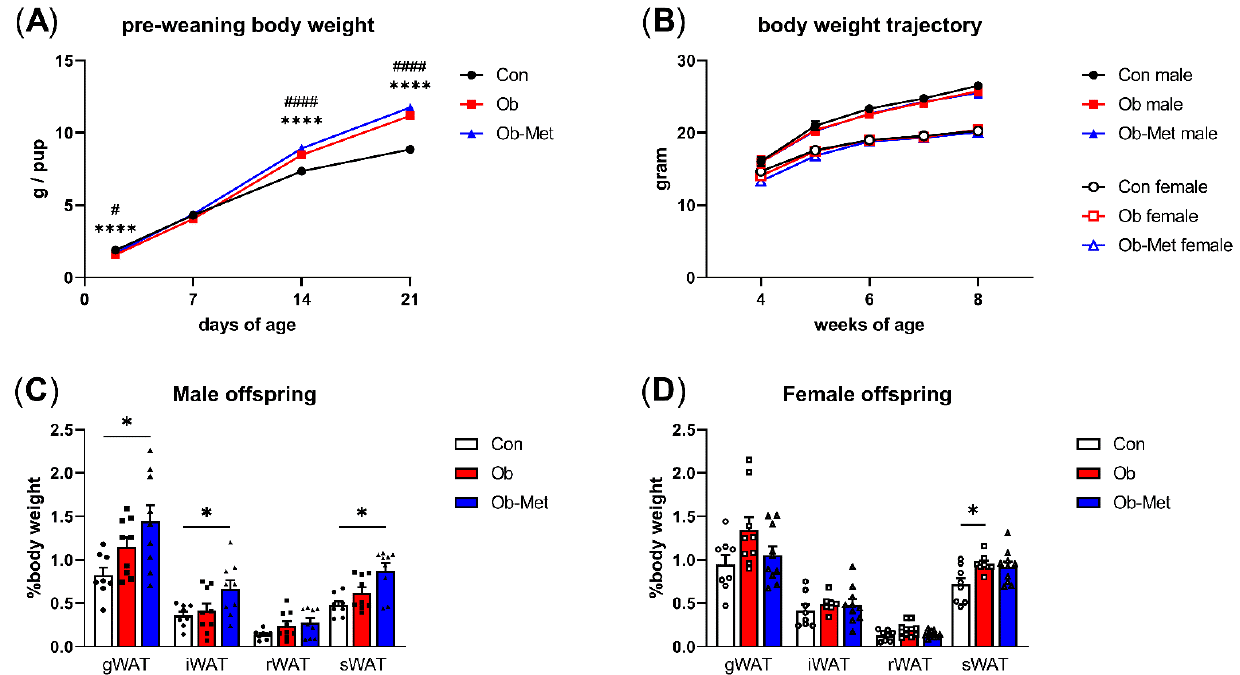
Figure 1. Offspring growth and adiposity in 8-week-old offspring. ( A ) Growth trajectory of neonatal offspring (n = 26–33 independent litters per group, sexes combined). **** p < 0.0001 vs. Con vs. Ob, # p < 0.05, #### p < 0.001 Con vs. Ob-Met using two-way ANOVA with Tukey’s multiple comparison test. ( B ) Post-weaning body weight trajectory in male and female offspring until 8 weeks of age (n = 10–14 independent litters per group). ( C , D ) Weight of white adipose tissue (WAT) depots collected at 8 weeks of age relative to offspring body weight (n = 8–10 independent litters per group). Outliers were excluded from ( C ) iWAT and sWAT; female Ob (Grubb’s method, outlier excluded values 1.03% and 1.45%, respectively). * p < 0.05 using one-way ANOVA with Tukey’s multiple comparison test. gWAT = gonadal depot, iWAT = intraperitoneal depot, rWAT = retroperitoneal depot, sWAT = subcutaneous depot. Con (circles, solid line) = offspring of control-fed dams, Ob (squares, dashed line) = offspring of obese dams, Ob-Met (triangles, dotted and dashed line) = offspring of obese metformin-treated dams. Panels ( B – D ): closed symbols denote male offspring; open symbols denote female